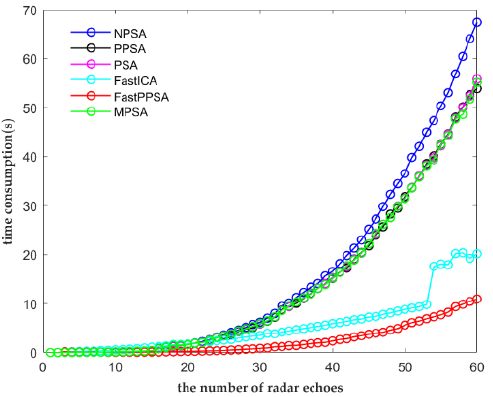
Figure 18. Time consumption comparison of FastICA, PSA, MPSA, NPSA, PPSA, and